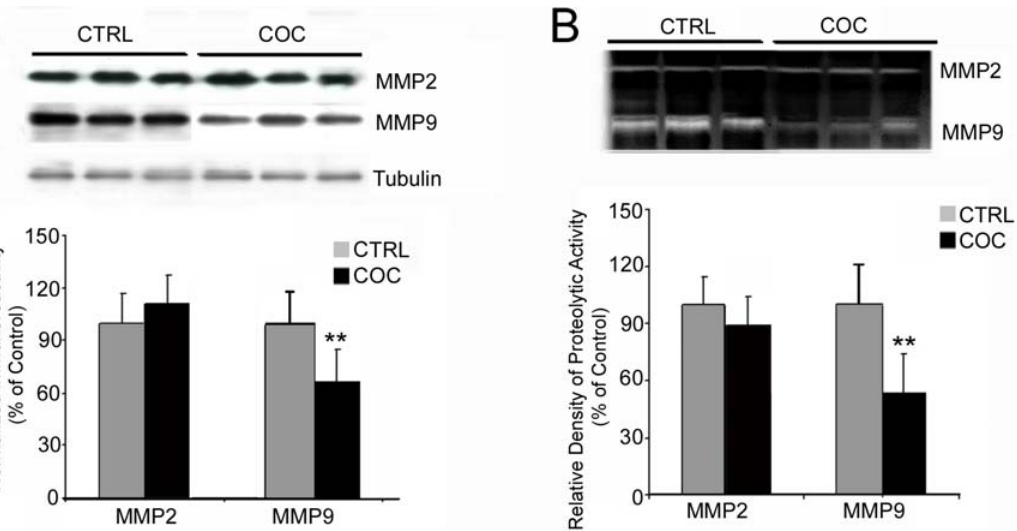
Figure 5. Regulation of MMP9 in human hippocampus with cocaine exposure . A, Representative Western immunoblots with antibodies against human MMP2 and MMP9 demonstrate down-regulation of MMP9 protein expression in cocaine abusers compared to age-matched controls subjects (n=8, respectively). The relative optical densities for active 92 kDa MMP9 and 72 kDa MMP2 illustrate quantitative fold change of MMP2 and MMP9 protein expression. Equal amount of total protein loading was confirmed by a -tubulin. B , Representative gel zymography. MMP9 activity in cocaine abusers compared with age-matched drug-free control subjects demonstrate decreased activity. The graphs illustrate quantitative zymography of MMP2 and MMP9. Levels of MMP2 activity were unchanged. Data are means 6 SEM. ** p =0.01 (one-tailed t-test).